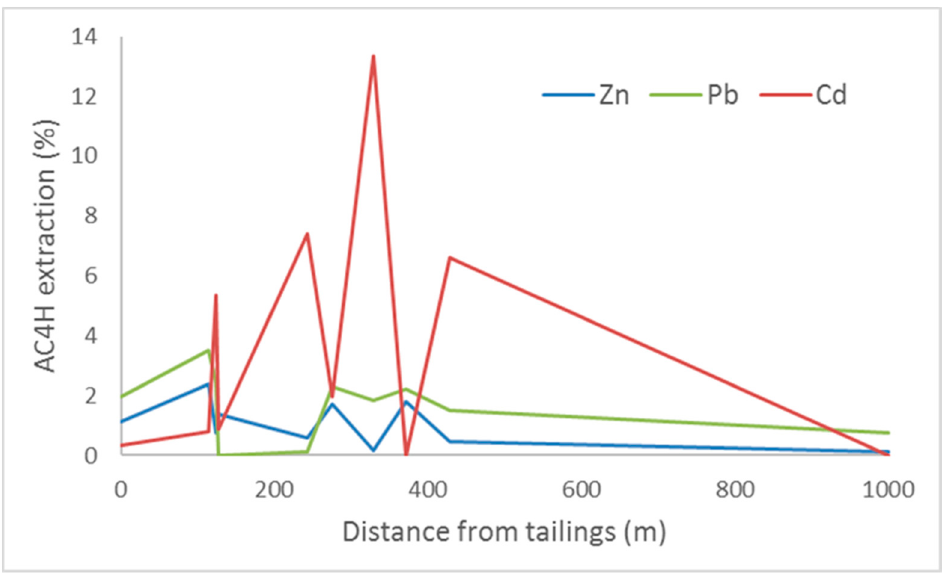
Figure 6. Evolution of the (bio)available fractions of Pb, Zn and Cd in the soil samples.